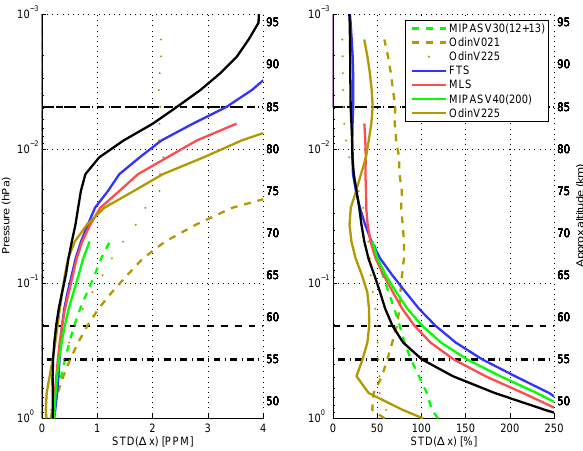
Fig. 12. Mean relative differences between satellites and OSO; (Left): the time period 2002–2004, MIPAS (12+13, green), SMR (V021, dashed brown) and SMR (V225, solid brown). (Right): the time period 2004–2008, FTS(blue), MIPAS (200, green), MLS (red) and SMR (V225, brown). The deviating lengths of the satellite pro- files is explained by the different vertical coverage of the satellites. The shaded areas show the estimated systematic error of the differ- ent satellites. The vertical black lines are the estimated systematic errors of the OSO instrument, 2002–2004 the worst case systematic error is used due to baseline problems (see Sect. 4.2). The horizontal black dashed lines show the vertical limits of the OSO observations. The summer values are excluded.